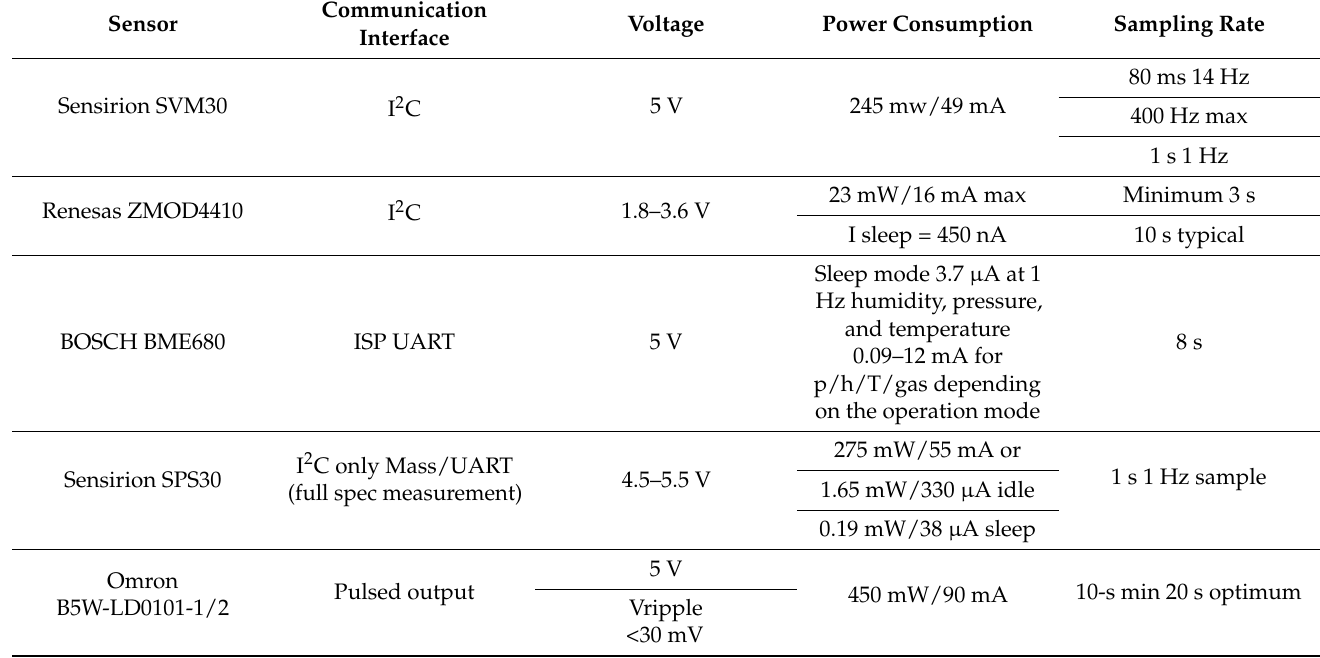
Table 4. Sensors’ communication and energy